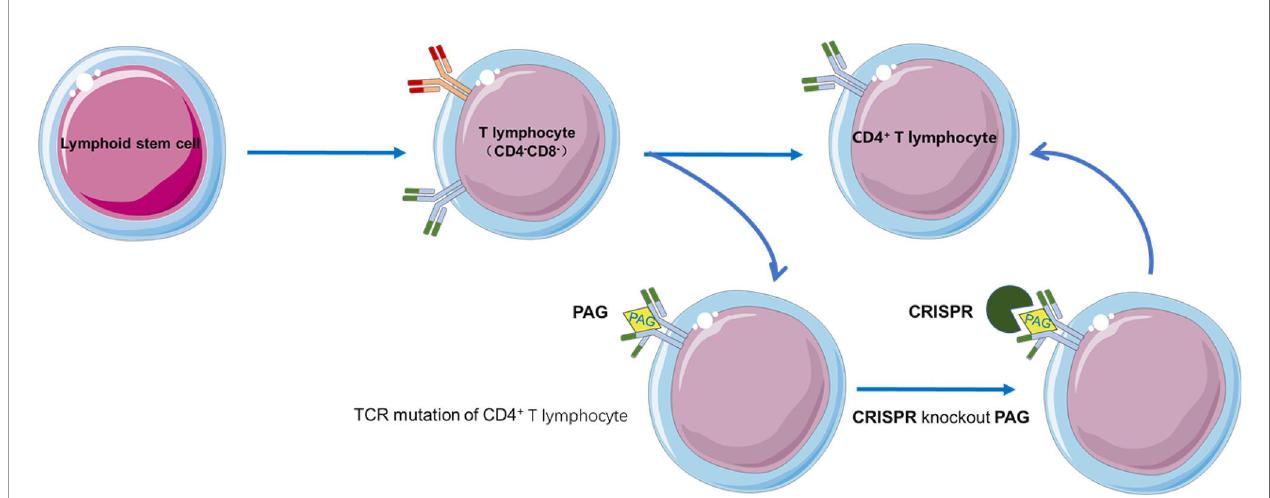
FIGURE 3 | RAG2 knockout by CRISPR-based genome editing in T-iPSCs prevents the additional TCR